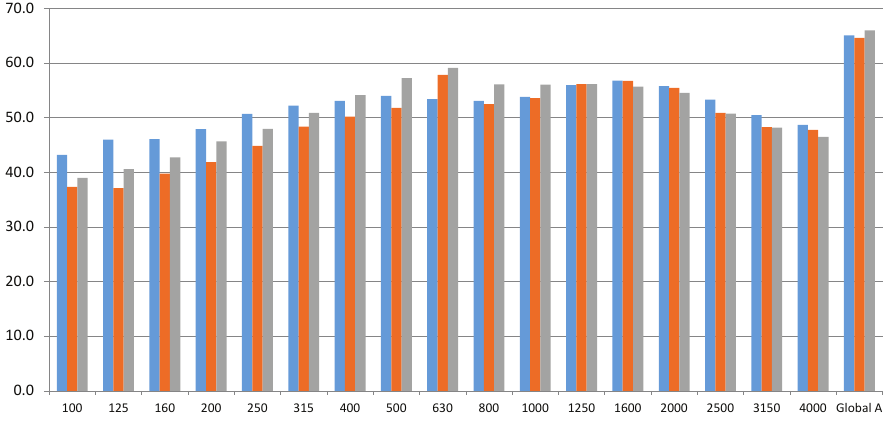
Figure 6. L Aeq,1h spectral comparison between DEUFRABASE calculations and measurements, in third octave band, for a dense asphalt (dense asphalt concrete (DAC) 0/10) pavement ( upper ) and a porous asphalt (porous asphalt (PA) 0/10) pavement ( lower ). DEUFRABASE predictions are based either using the mean emission spectrum (‘worst’ prediction) or using the measured spectrum (‘intermediate’